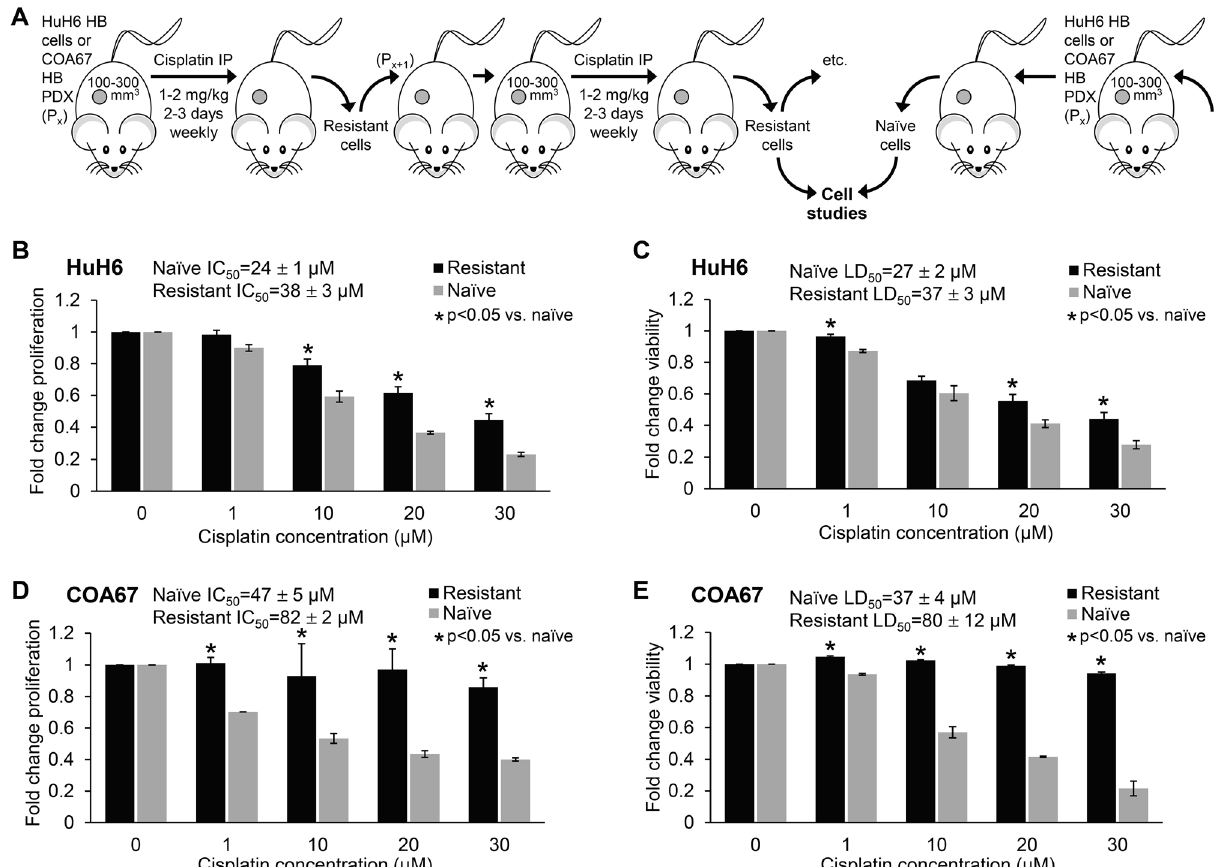
Figure 1. Development of a hepatoblastoma cisplatin-resistant xenograft model. ( A ) Human hepatoblastoma cells, HuH6, or hepatoblastoma patient-derived xenografts, COA67, were injected or implanted, subcutaneously, into the flank of one female athymic nude mouse each. Once tumor volume reached 100 mm 3 for HuH6 and 300 mm 3 for COA67, the animal was treated with cisplatin via intraperitoneal injection (2 mg/kg/day for 3 consecutive days weekly for HuH6 and 1 mg/kg/day for 2 consecutive days weekly for COA67). Tumors were harvested to yield “cisplatin-resistant” cells, which were used for studies, and serially passed into a second mouse. Alternatively, tumors from mice not treated with cisplatin were utilized as controls, yielding “cisplatin- naïve” HuH6 and COA67 cells. ( B – E ) Cisplatin-resistant and cisplatin-naïve cells were treated with cisplatin at increasing concentrations (0 to 30 µM) for 72 h, and cell proliferation and viability were measured with CellTiter 96 and alamarBlue assays, respectively. ( B , D ) Proliferation and ( C , E ) viability was less affected given the same dose of cisplatin in resistant compared to naïve cells. The IC 50 and LD 50 values were calculated following treatment with cisplatin. Resistant cells had a higher IC 50 and higher LD 50 compared to naïve cells. These findings confirmed the cisplatin resistance model in both HuH6 and COA67 hepatoblastoma xenografts. Data reported as mean ± To validate and corroborate the findings of the kinome assay, immunoblotting was performed for PIM3 expression. Immunoblotting demonstrated increasing PIM3 expression in both HuH6 and COA67 with increas- ing insensitivity to cisplatin (Fig. 3B), indicating that PIM3 expression correlates with cisplatin resistance in hepatoblastoma. PIM inhibition with AZD1208 increases sensitivity of cisplatin-resistant hepatoblastoma cells to cisplatin. Proliferation of cisplatin-resistant HuH6 and COA67 cells was assessed in the presence of both cisplatin and/or the PIM inhibitor, AZD1208. The addition of 1 µM of AZD1208 to cisplatin in both HuH6 and COA67 cisplatin-resistant hepatoblastoma cells resulted in decreased proliferation to levels of cisplatin-naïve cells treated with cisplatin alone (0.59 ± 0.04 fold change proliferation in HuH6 cisplatin-resistant cells treated with cisplatin and AZD1208 vs. 0.60 ± 0.01 fold change proliferation in HuH6 cisplatin-naïve cells, p = 0.38, Fig. 3C, and 0.56 ± 0.12 fold change proliferation in COA67 cisplatin-resistant cells treated with cisplatin and AZD1208 vs. 0.53 ± 0.03 fold change proliferation in COA67 cisplatin-naïve cells, p = 0.43, Fig. 3D), indicating that PIM inhibition with 1 µM of AZD1208 sensitized HuH6 and COA67 cisplatin-resistant cells to cisplatin. Treatment with both AZD1208 and cisplatin significantly decreased proliferation in both HuH6 and COA67 cisplatin-resistant hepatoblastoma cells compared to either drug alone and to untreated controls (p < 0.05, Fig. 3C,D).